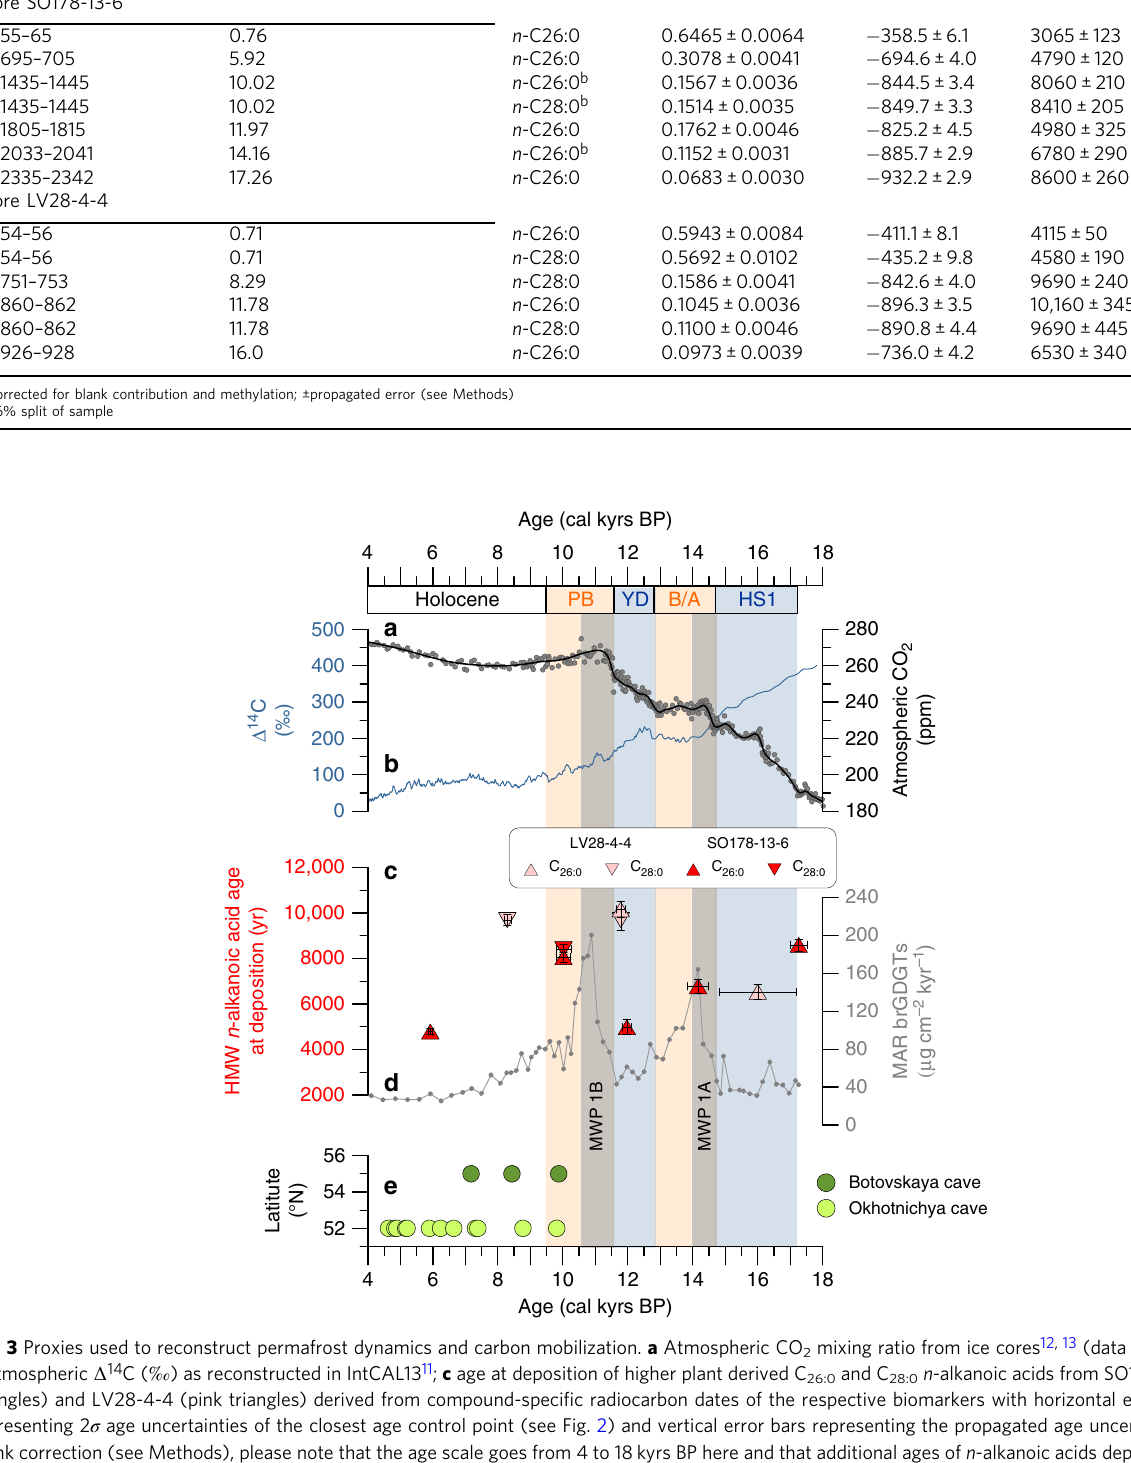
Table 1 Compound-speci fi c radiocarbon data ± propagated errors ( σ ) of long-chain n -alkanoic acids for cores SO178-13-6 and LV28-4-4 Sample depth (cm below surface)